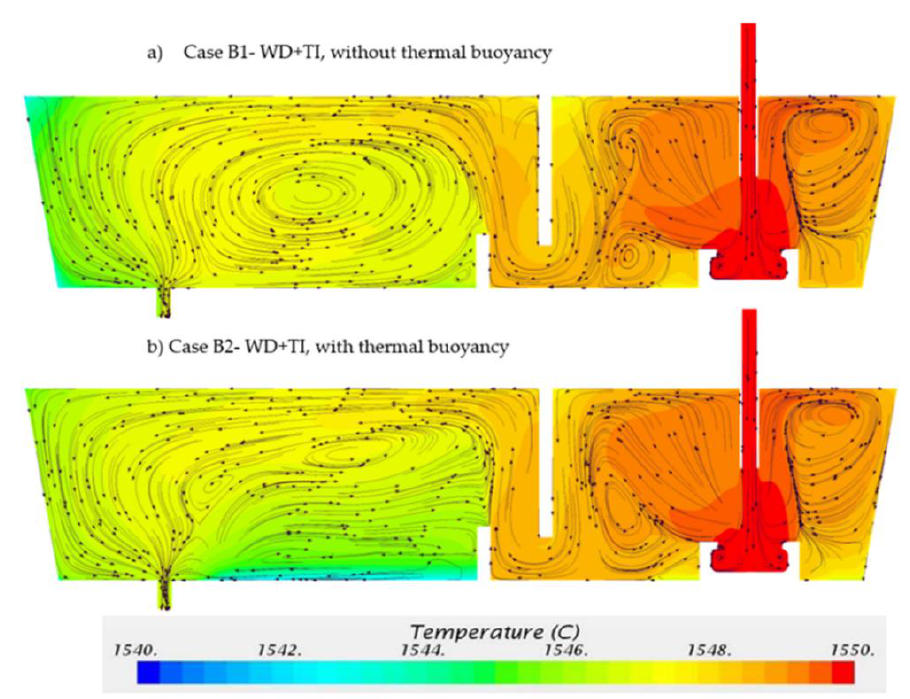
Figure 13. Temperature and flow pattern in ( a ) Case B1—without thermal buoyancy and ( b ) Case B2—with thermal buoyancy.